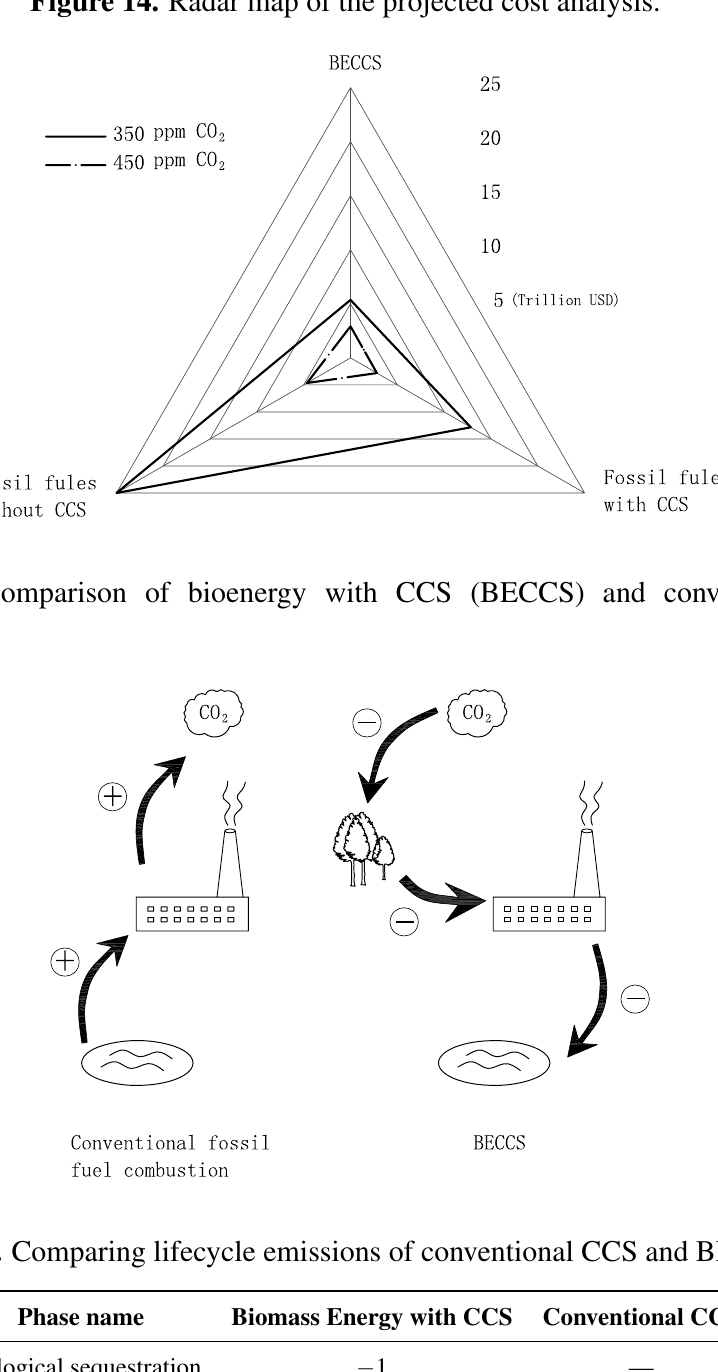
Figure 14. Radar map of the projected cost analysis.